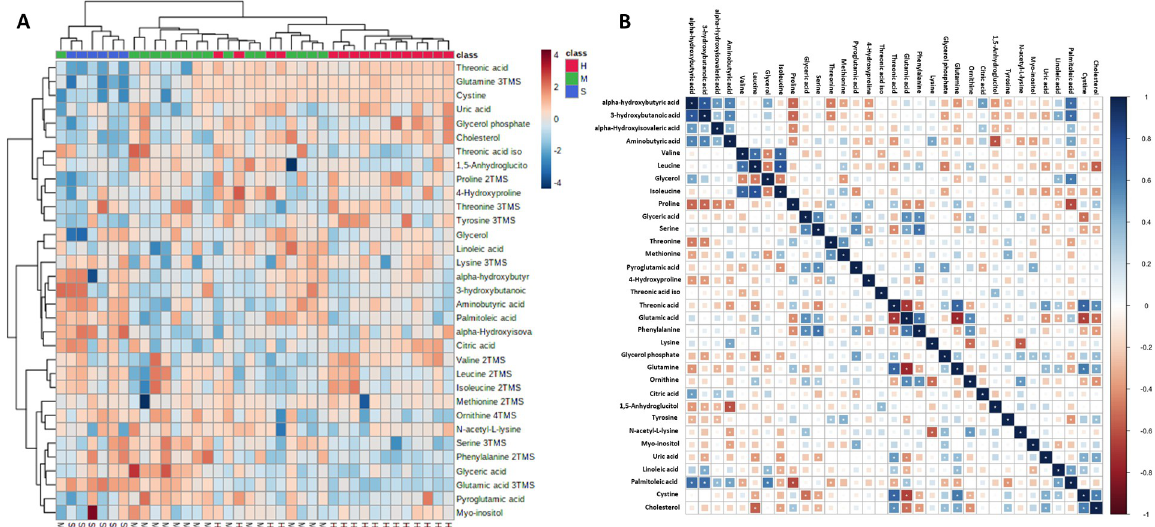
Fig 1. Untargeted serum metabolomics of COVID-19 patients. A. Heatmap and hierarchical clustering analysis of COVID-19 and control individuals with all the metabolites included in the analysis. Different intensities in red and blue colors in the heatmap and scale bar at the right side of the figure, denotes increased or reduced levels, respectively. B. Spearman correlation analysis of serum metabolites in COVID-19 and control groups. H, healthy controls, M, mild/moderate disease; S, severe disease. Blue numbers indicate a positive association. Red numbers indicate a negative association. Asterisks denote statistical significance with p-value < 0.05. The exact p-values of Spearman´s correlation analysis is depicted in S3 Table.